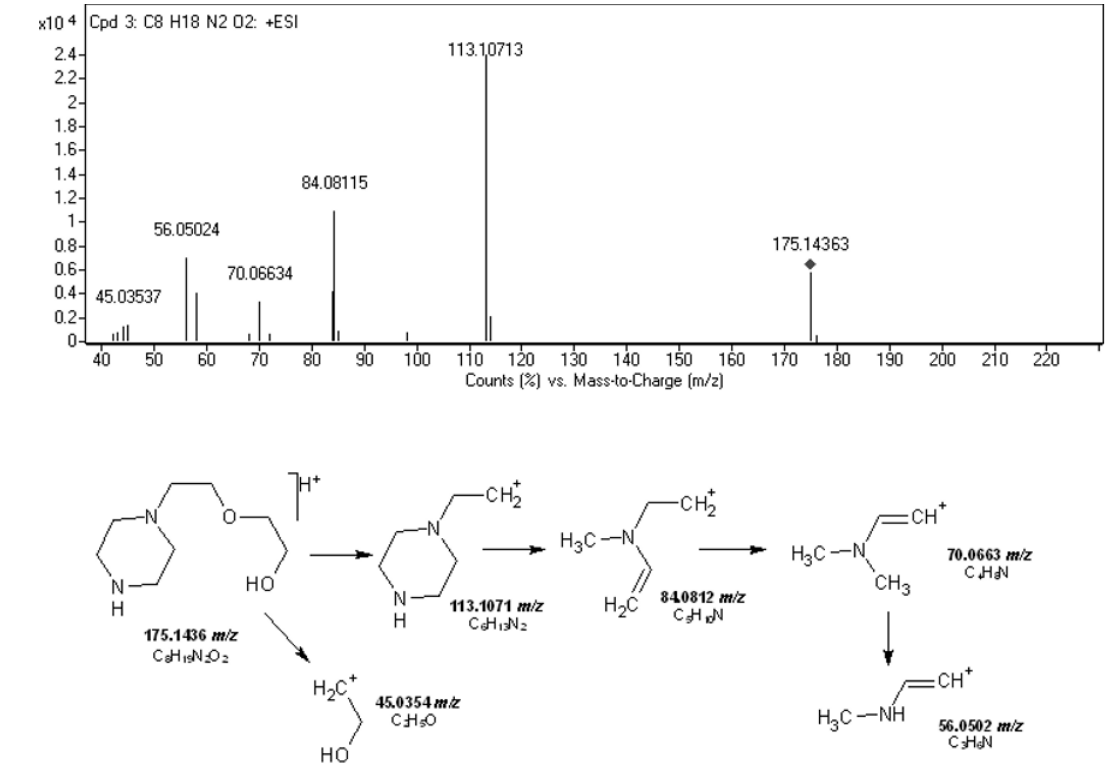
Figure 4. Q-TOF MS/MS spectrum and fragmentation pathway of photodegradation product D2 ( t